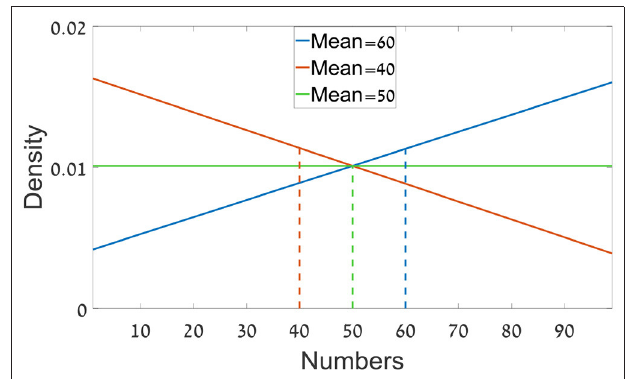
FIGURE 7 | The distributions from which the numbers were sampled in Experiment